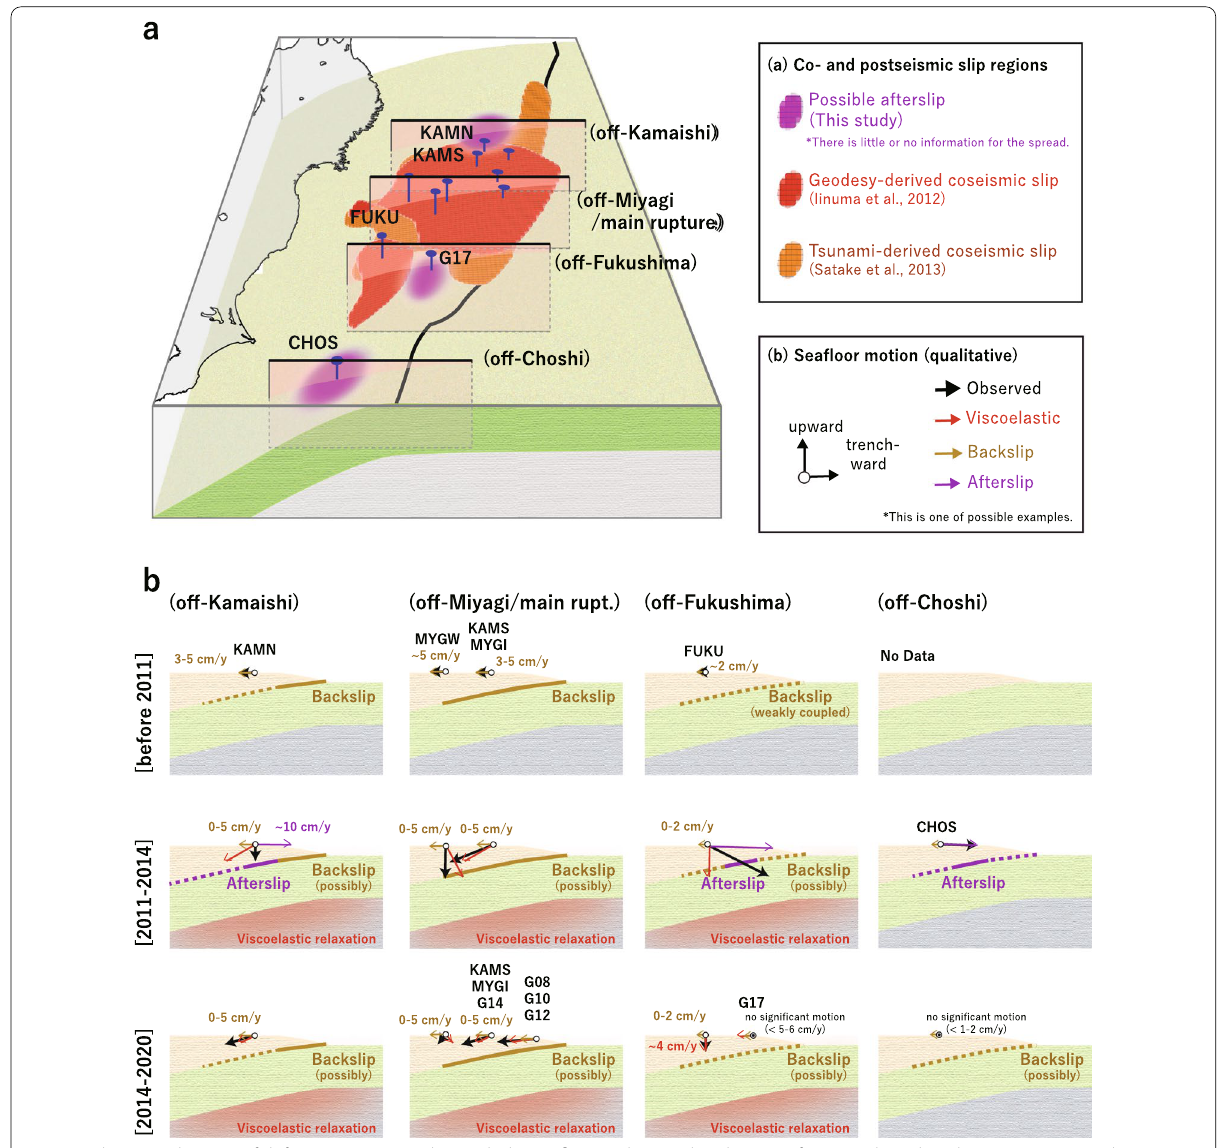
Fig. 3 Schematic diagram of deformation sources beneath the seafloor. a Slips on the plate interface. Purple, red, and orange regions indicate possible afterslip region and geodetically derived (Iinuma et al. 2012) and tsunami‑derived (Satake et al. 2013) coseismic slip areas of the 2011 Tohoku‑oki earthquake, respectively. Blue circles and bars indicate the locations of GNSS‑A sites and their projections to the plate interface, respectively. Black rectangles show the locations for cross sections illustrated in subsequent panels. Note that little or no information for the spread of afterslip regions can be added by the present GNSS‑A data. b Cross sections for each region with one of possible qualitative explanations for the contributions of each deformation source to the motion at GNSS‑A sites. Black, red, purple, and yellow arrows indicate the observed motion and components due to viscoelastic relaxation, afterslip, and interplate coupling,